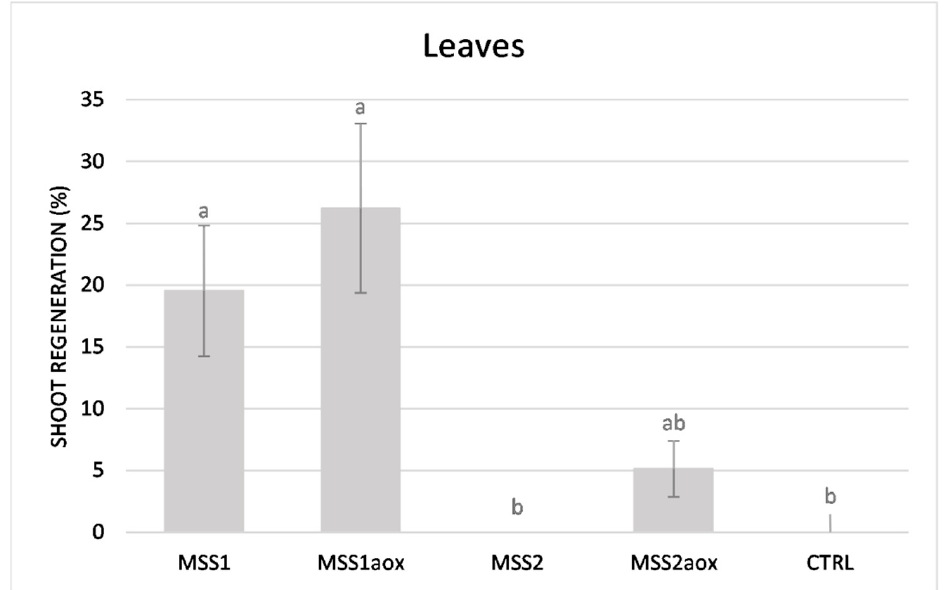
Figure 2. Influence of the hormones and antioxidants on the regeneration aptitude observed from in vivo and in vitro first true leaves as starting materials (data recorded after 2 months). Error bars represent standard error. Different letters indicate significant differences between treatments at p < 0.05 (Tukey HSD test’s results). For culture media acronym, refer to Table 1 (MSS1: shoot multiplication medium B + 1 mg/L BA; MSS1aox: shoot multiplication medium B + 1 mg/L BA + citric acid (10 mg/L) + ascorbic acid (100 mg/L); MSS2: shoot multiplication medium B + 4 mg/L TDZ; MSS2aox: shoot multiplication medium B + 4 mg/L TDZ + citric acid (10 mg/L) + ascorbic acid (100 mg/L); CTRL: control, MSS